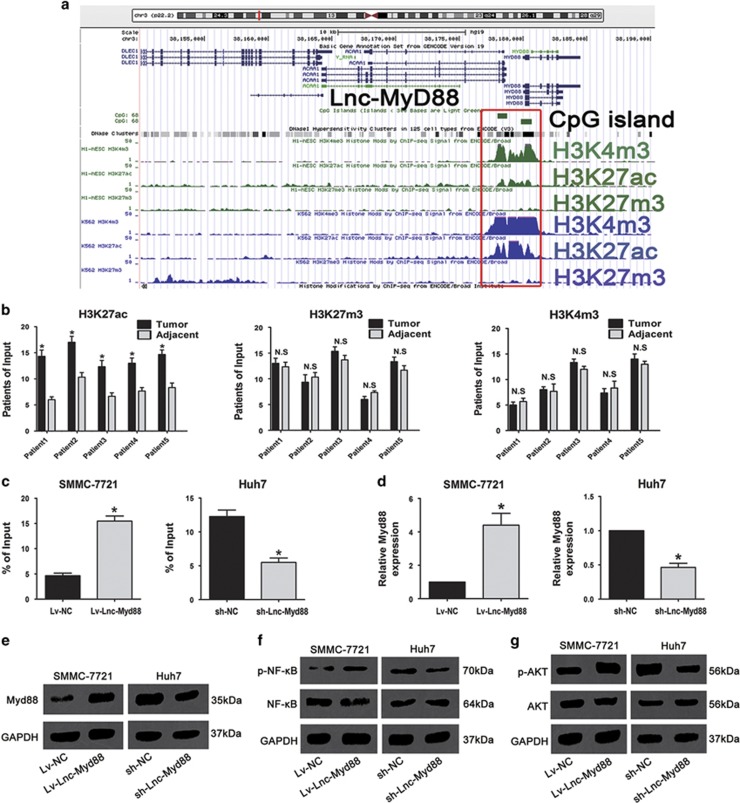
Lnc-Myd88 induces an upregulation of Myd88 by enhanced acetylation of the promoter of Myd88 and then activates NF-κB and PI3K/AKT signal pathways. (a) Enrichment prediction of H3K4m3, H3K27Ac and H3K27m3 in the promoter region of Myd88 through ENCODE database. (b) The enrichment of H3K4m3, H3K27Ac and H3K4m3 in the promoter region of Myd88 in HCC patients. (c) The alteration of the enrichment of H3K27Ac in the promoter region of Myd88 in HCC cells treated with Lnc-Myd88. (d and e) The alteration of mRNA and protein level of Myd88 in HCC cells induced by Lnc-Myd88. GAPDH was used as a loading control. (f and g) The levels of NF-κB, p-NF-κB, AKT, p-AKT and GAPDH were examined by western blotting in SMMC-7721 and Huh7 cells treated with Lnc-Myd88. The experiments were performed in triplicate; the data are expressed as the mean±S.E.M. (*P<0.05, **P<0.01)